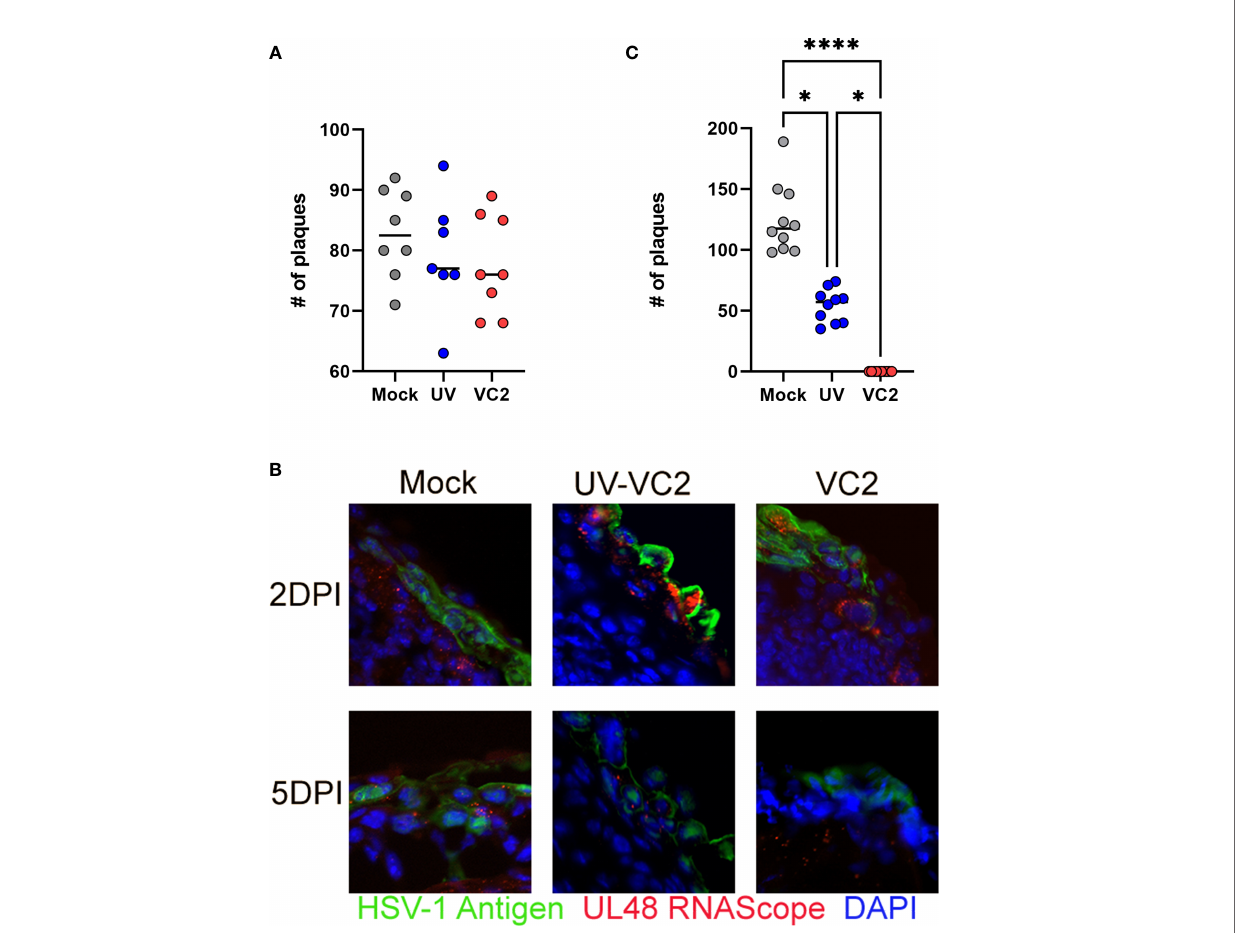
FIGURE 2 | Neutralizing antibodies in mouse tears and post-challenge viral replication in ocular tissues. (A) Neutralization of virus after the incubation with tear fl uids. (B) Viral replication in ocular tissues following challenge at 2- & 5DPI detected by IFM and RNAScope assays. Detection of viral antigens (green) HSV-1 UL48 transcripts (red). (C) Viral shedding on ocular surfaces quanti fi ed by plaque assay at 5DPI. *<P=0.05, ****<P=0.0001 by One-Way